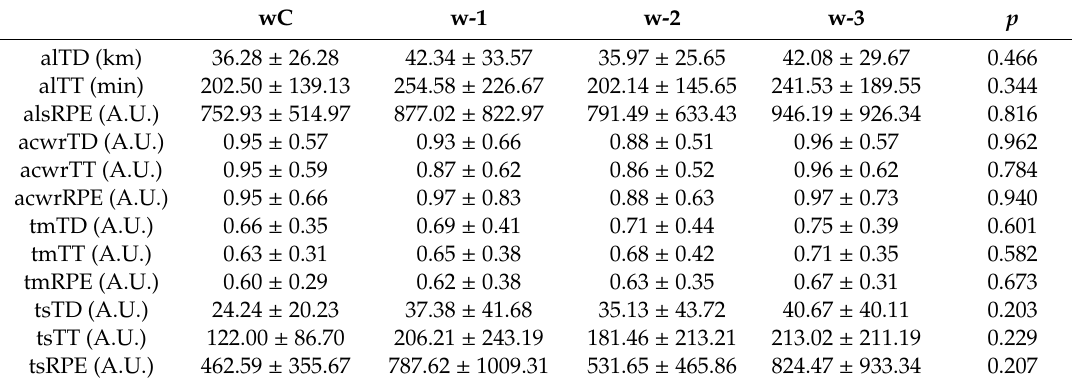
Table 2. Descriptive statistics of workload measures before short trail (ST)